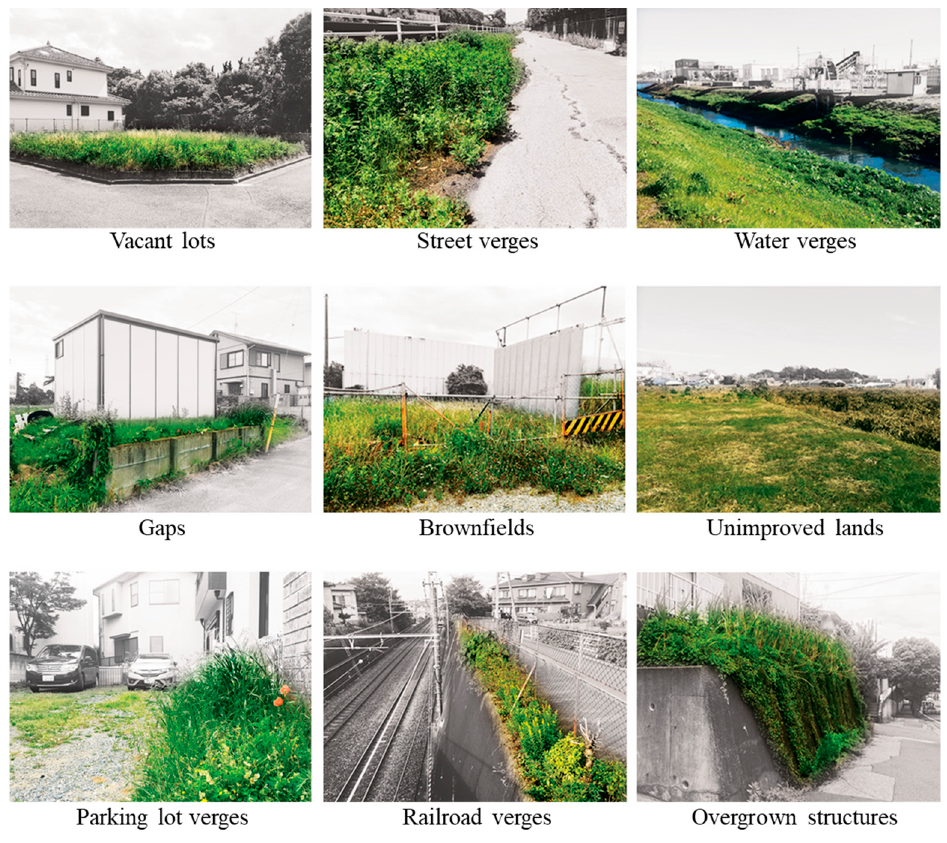
Figure 3. Nine types of IGS in Ichikawa.